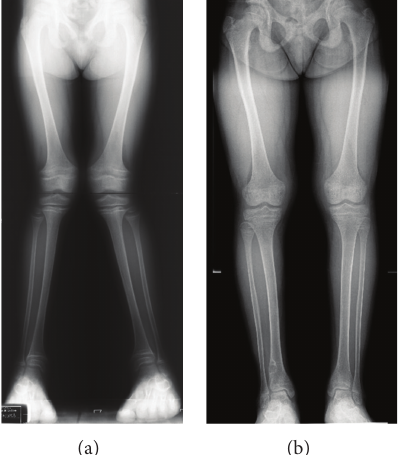
Figure 2: Radiograph of both lower extremities in a standing view. (a) Marked genu valgum deformity (24-degree angulation on the left and 20 degrees on the right) was noted at 5 years of age before phosphate and calcitriol therapy was commenced. (b) Marked improvement in genu valgum and healing of rickets at 10 years of age (4-degree angulation on the left and 5 degrees on the right).